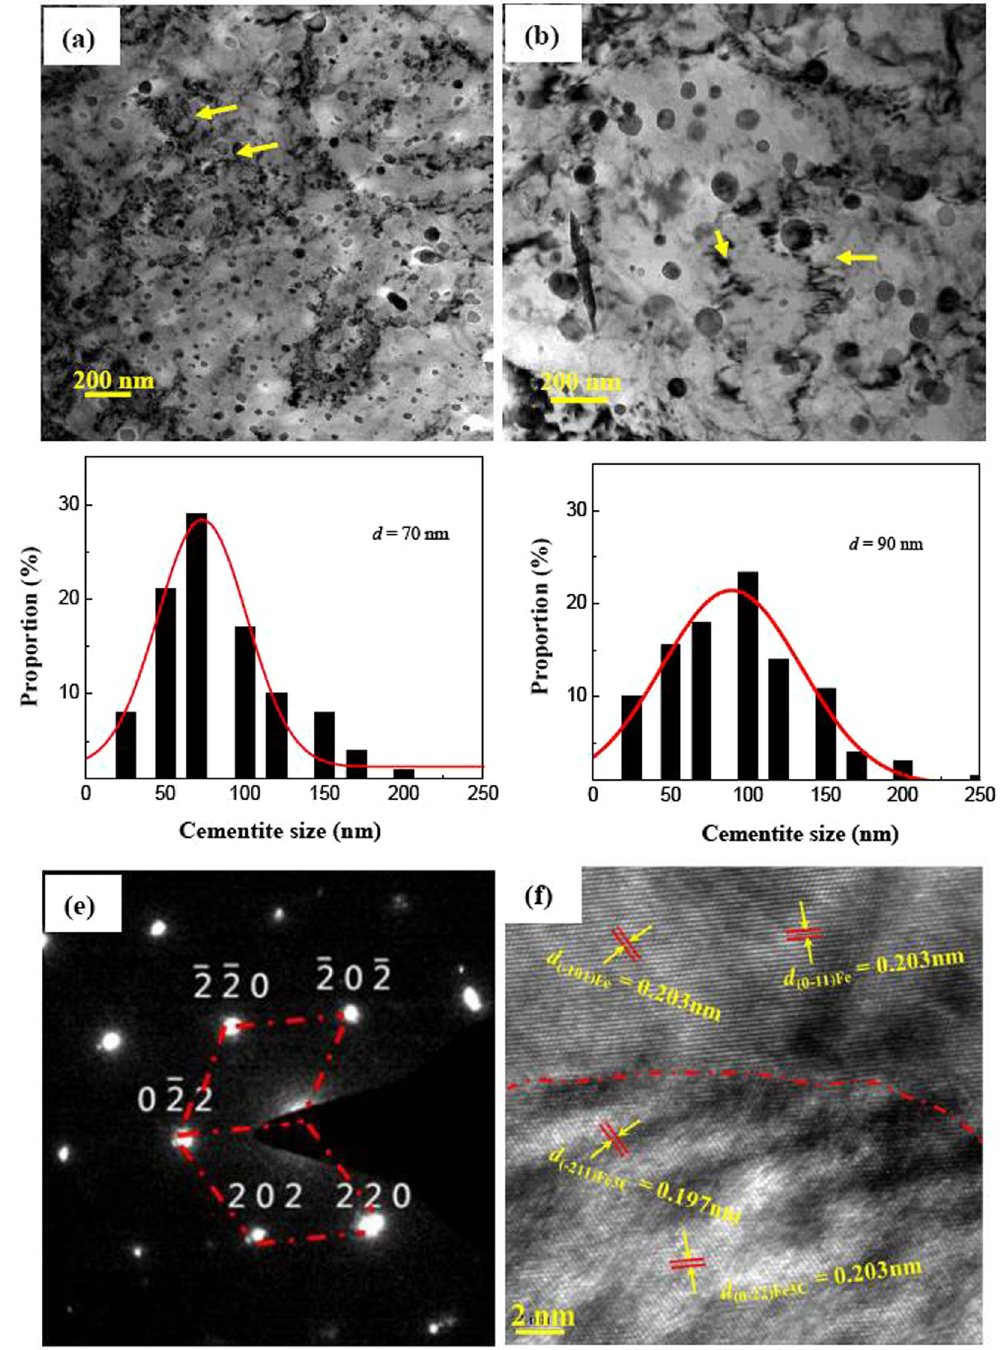
Figure 4. TEM micrographs of ( a ) UFG-1 and ( b ) UFG-2 steels observed along the α [010] zonal axis. ( e ) Shows selected-area-electron-diffraction (SAED) patterns of Fe 3 C particles. ( f ) Is the high-resolution TEM (HRTEM) image of cementite and ferrite. UFG-1 steel: ferrite ( D = 430 nm) + spheroidized cementite ( d = 70 nm); UFG-2 steel: ferrite ( D = 680 nm) + spheroidized cementite ( d = 90